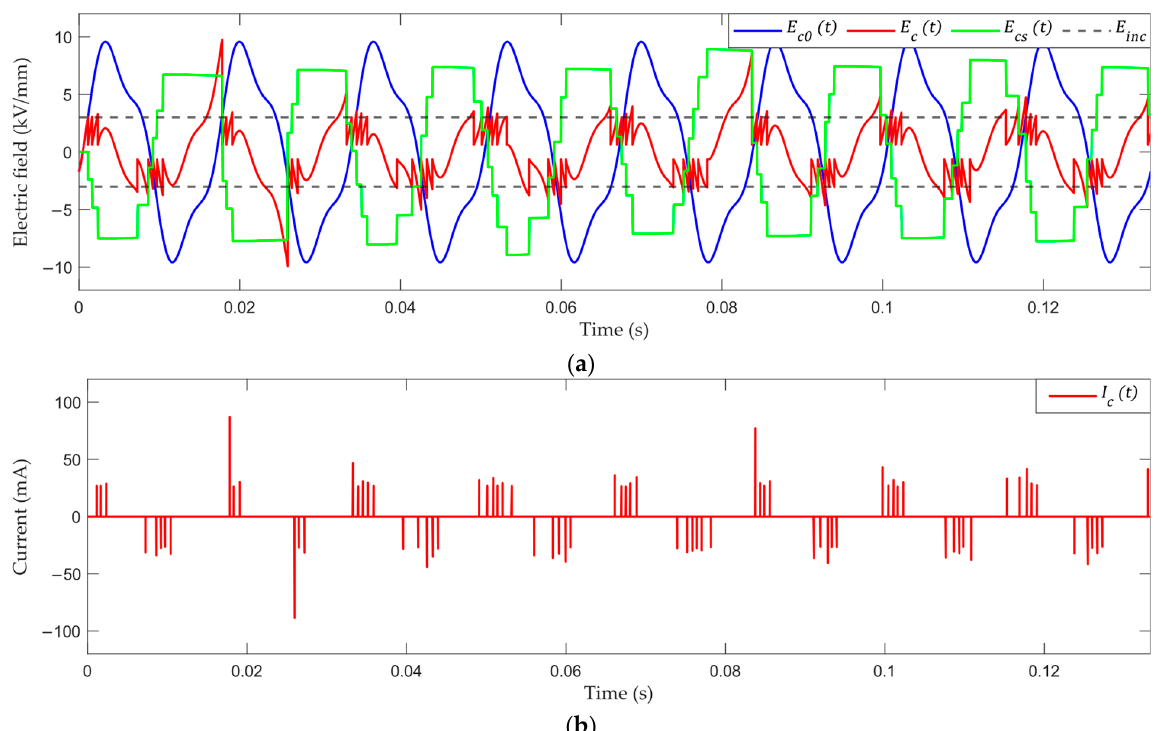
Figure 14. Simulated results for the case wherein a voltage distorted by the 3rd harmonic component with 𝜑 (cid:3035) = 180° and THD = 20% was applied: ( a ) electric fields over time; ( b ) PDs current pulses.